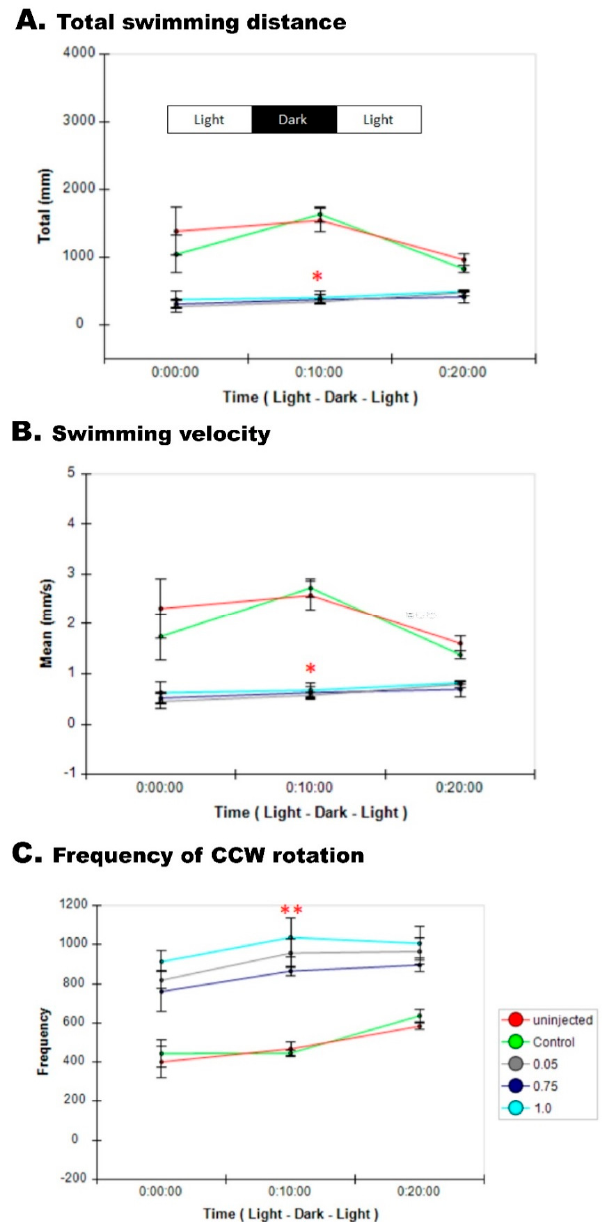
Figure 7. Impaired sensory response in zebrafish pgap3 morphants. Knockdown of Pgap3 resulted in reduced responses to the sensory trigger represented by less velocity and total distance moved per larvae over time assessed by locomotive behavior recording through the presentation of light-dark cycles over a time interval of 30 min. ( A ) Total distance moved by larvae calculated using Ethovision software (Noldus), pgap3 morphants had significantly less total distance moved, * p < 0.05. ( B ) Velocity of larvae calculated using Ethovision software (Noldus), pgap3 morphants had a significant reduction in velocity, * p < 0.05. ( C ) Frequency pf counter-clockwise rotation of larvae calculated using Ethovision software (Noldus), pgap3 morphants had a substantial increase in frequency, ** p < 0.001. The total number of larvae examined: 6 from each group of uninjected, control MO, pgap3 MO 0.5, 0.75 and 1.0 mM. Statistical analysis was performed with one-way ANOVA followed by Dunnett’s test for multiple comparisons using GraphPad Prism (version